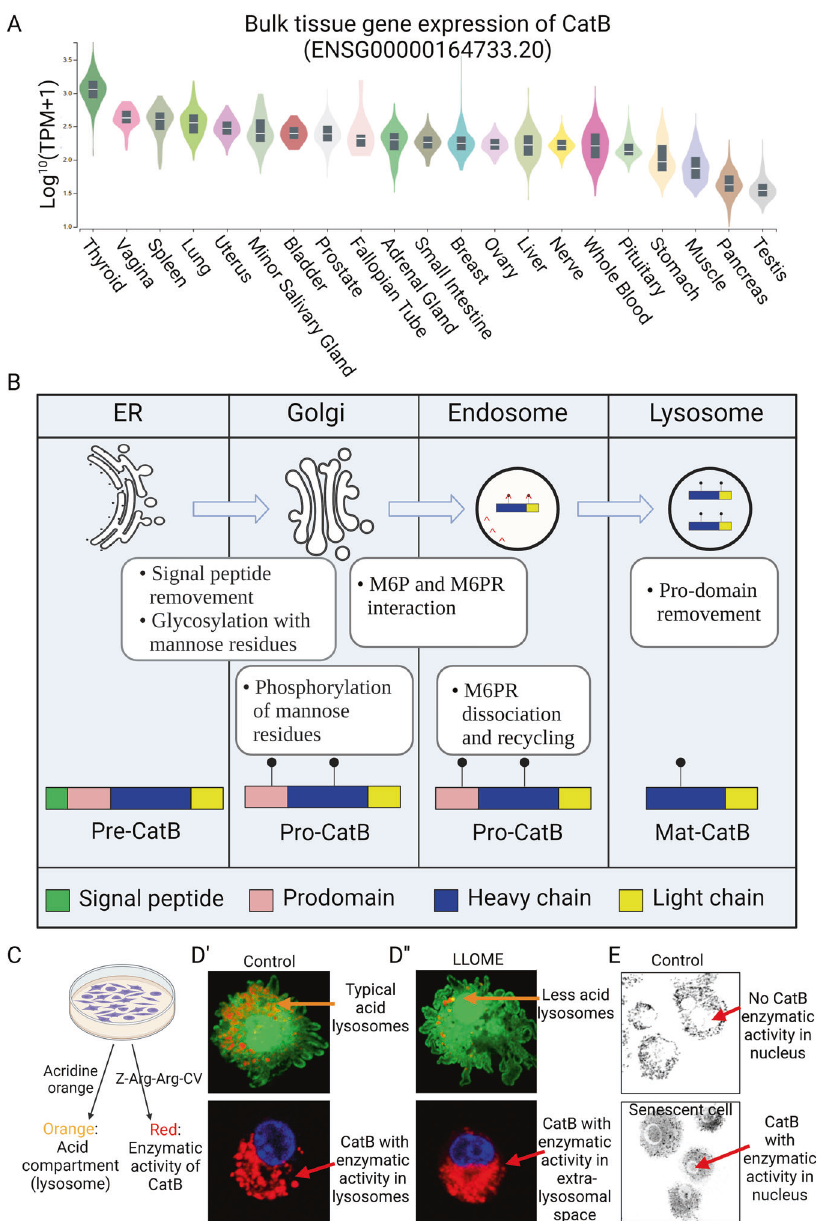
Fig. 1 CatB expression, maturation, and cellular distribution. A CatB expression in various tissues. The data were obtained from the Genotype-Tissue Expression (GTEx) Project (https://gtexportal.org). Expression values are shown in TPM (transcripts per million), calculated from a gene model with isoforms collapsed to a single gene. B CatB maturation and lysosome-sorting pathway. C Methods to examine the lysosomal acid condition and CatB enzymatic activity. D ’ Puncta signals (orange) of lysosomes with the acid environment and puncta signals (red) of CatB with enzymatic activity. D ” LLOME increases the permeability of the lysosome membrane, resulting in a smaller number of acid lysosomes. LLOME-treated cells showed diffused CatB enzymatic activity. E Senescent cells showed CatB enzymatic activity in the nucleus but were not found in control